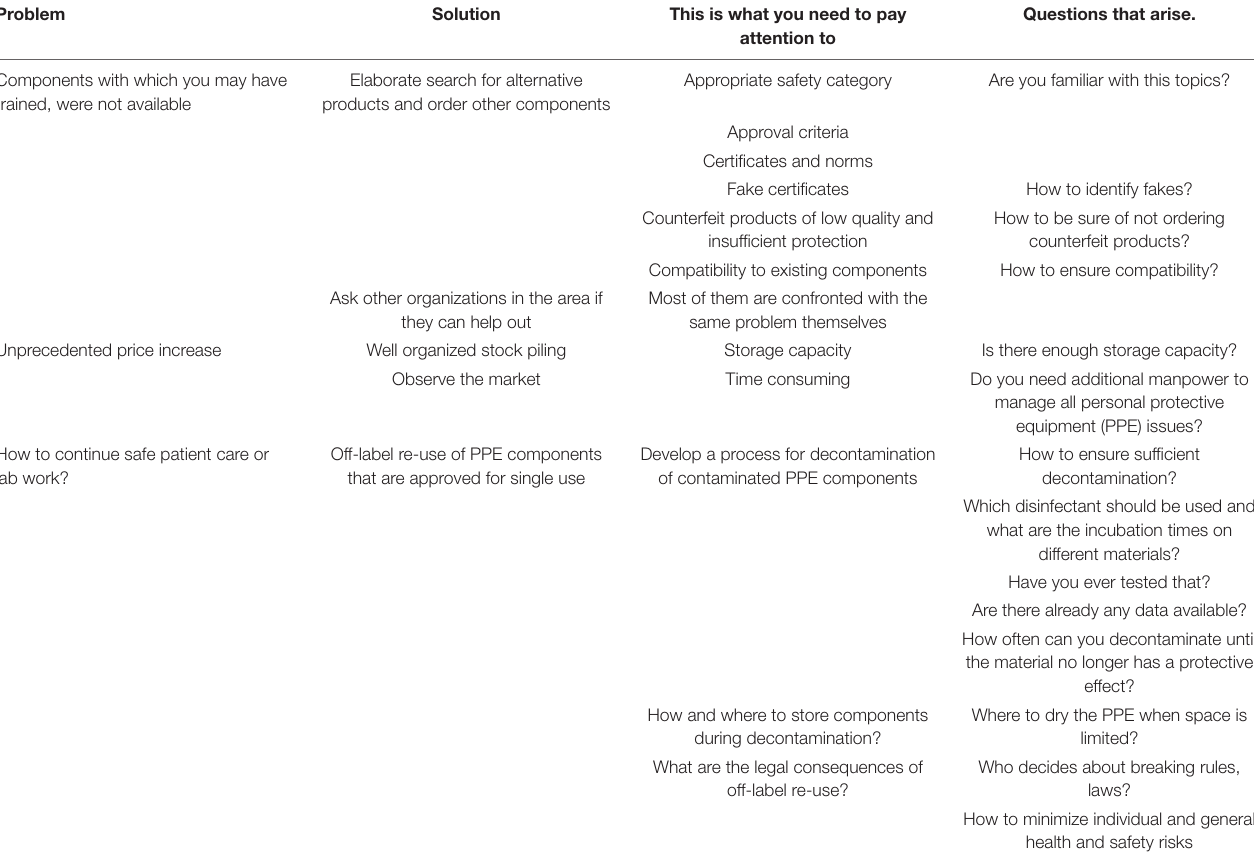
TABLE 2 | Challenges due to supply bottlenecks, proposed solutions and questions.